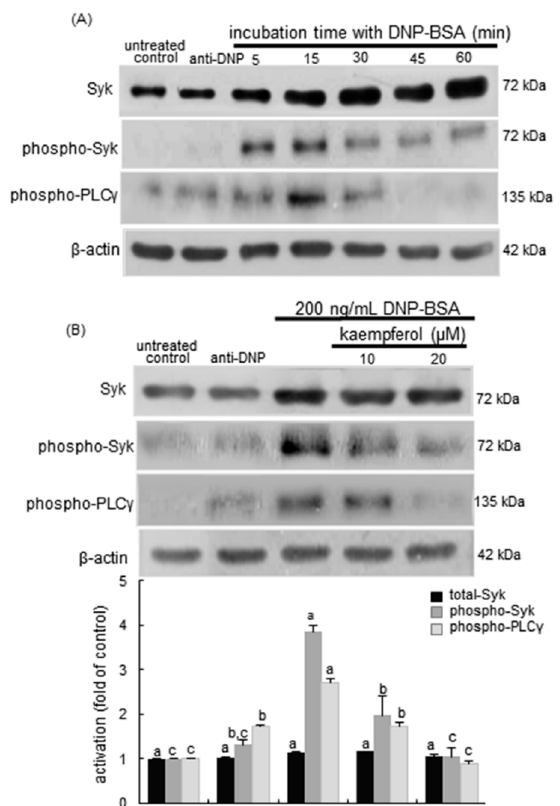
Figure 7. Temporal response of the activation of Syk and phospholipase C γ (PLC γ ) ( A ) and inhibitory effects of kaempferol on the activation of Syk and PLC γ ( B ) in RBL-2H3 cells. Rat basophilic leukemia RBL-2H3 cells were sensitized by adding 0.5 μ g/mL anti-2,4-dinitrophenol (anti-DNP) and stimulated for 5–60 min with 200 ng/mL of DNP-bovine serum albumin (BSA) in the absence and presence of 10–20 μ M kaempferol. Equal amounts of cell lysate proteins were subject to 8% SDS-PAGE and Western blot analysis with a primary antibody against total Syk, phospho-Syk and phospho-PLC γ (three separate experiments). β -Actin protein was used as an internal control for cellular total Syk, phospho-Syk, and phospho-PLC γ . The bar graphs (mean ± SEM) in the bottom panel represent quantitative results obtained from a densitometer. Values not sharing a common letter refer to significantly different at p < 0.05.